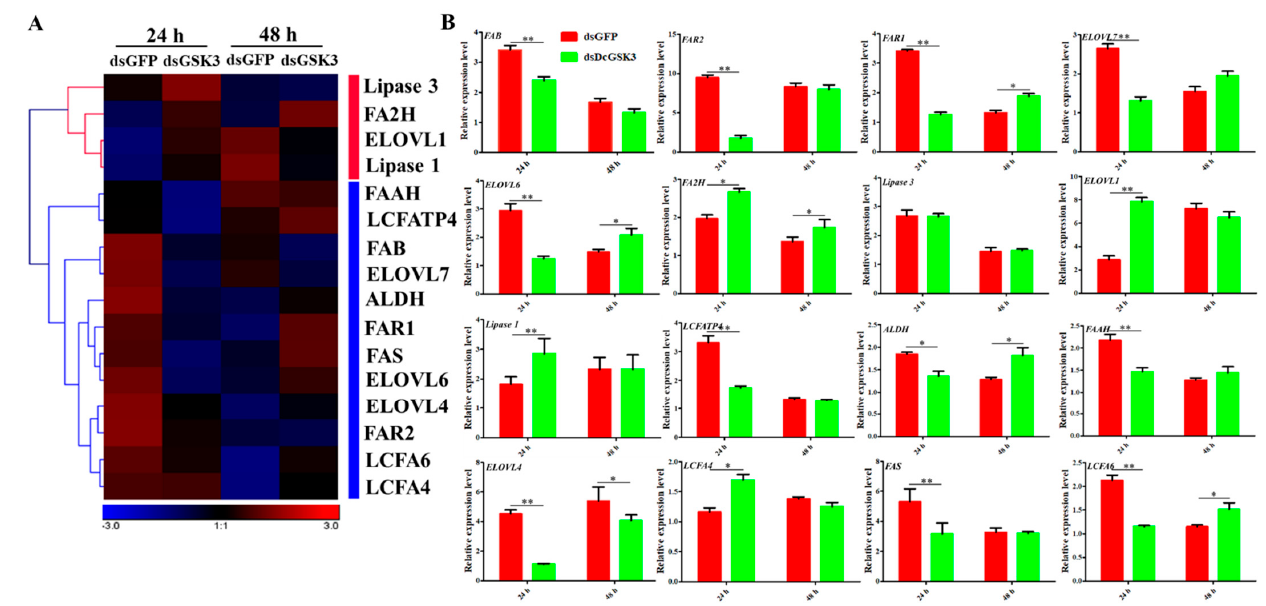
Figure 13. Hierarchical analysis for genes involved in fatty acid metabolism in different comparable groups. ( A ) Hierarchical analysis for DEGs involved in fatty acid metabolism in different comparable groups. DEG expression is shown with a pseudocolor scale (from − 3 to 3), with a red color indicating high expression levels and a bluish-violet color indicating low expression. ( B ) The relative expression level analysis of 16 DEGs involved in fatty acid metabolism at 24 h and 48 h after inhibition of DcGSK3 . The asterisks indicate significance differences by * ( p < 0.05) and ** ( p <